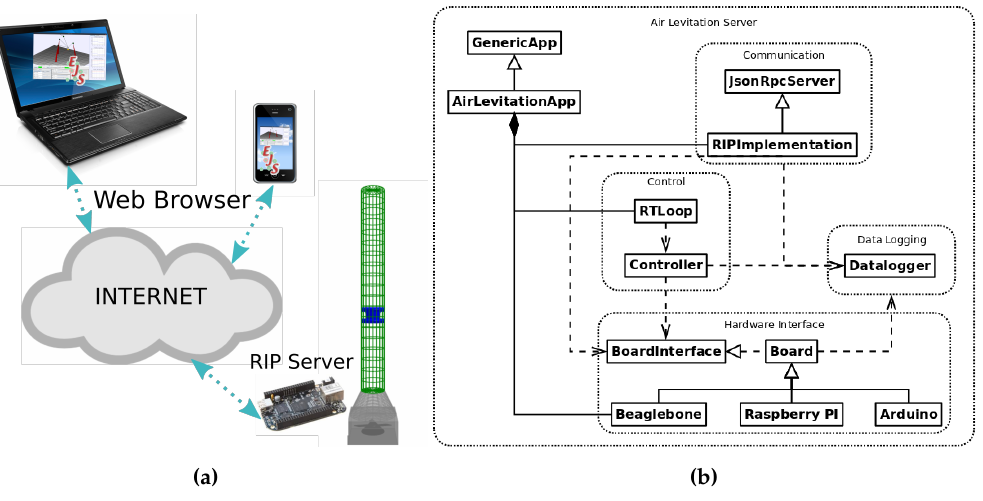
Figure 3. ( a ) Overall system view, and ( b ) RIP software